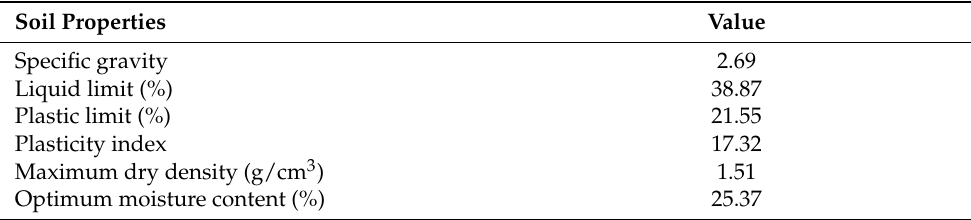
Table 1. Physical and mechanical properties of soil sample.